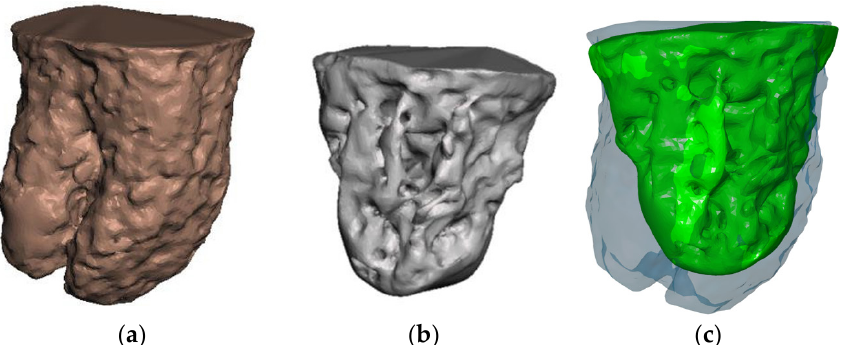
Figure 7. Surface 3D models of reconstructed cavities ( a ) after the first CBCT imaging and ( b ) after the second CBCT imaging and ( c ) overlap of surface 3D models of the first (bluish transparent color) and second CBCT measurement (green color) of the same patient.